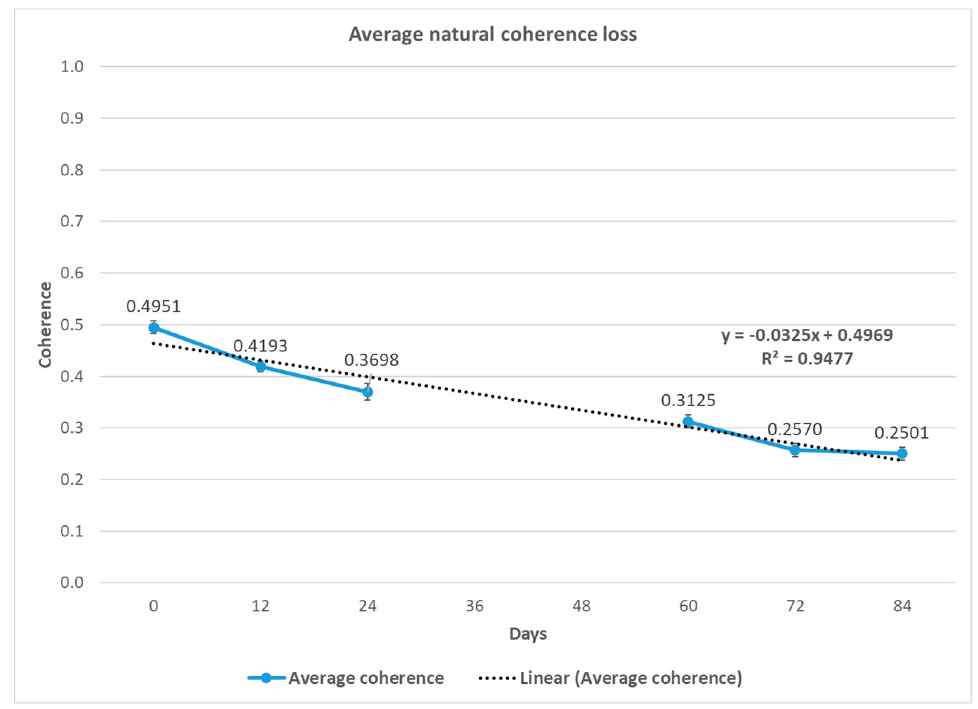
Figure 17. Natural coherence loss. Coherence, ranging from 0 to 1 is on the y-axis, whereas the days since the date of the first SAR acquisition are on the x-axis.